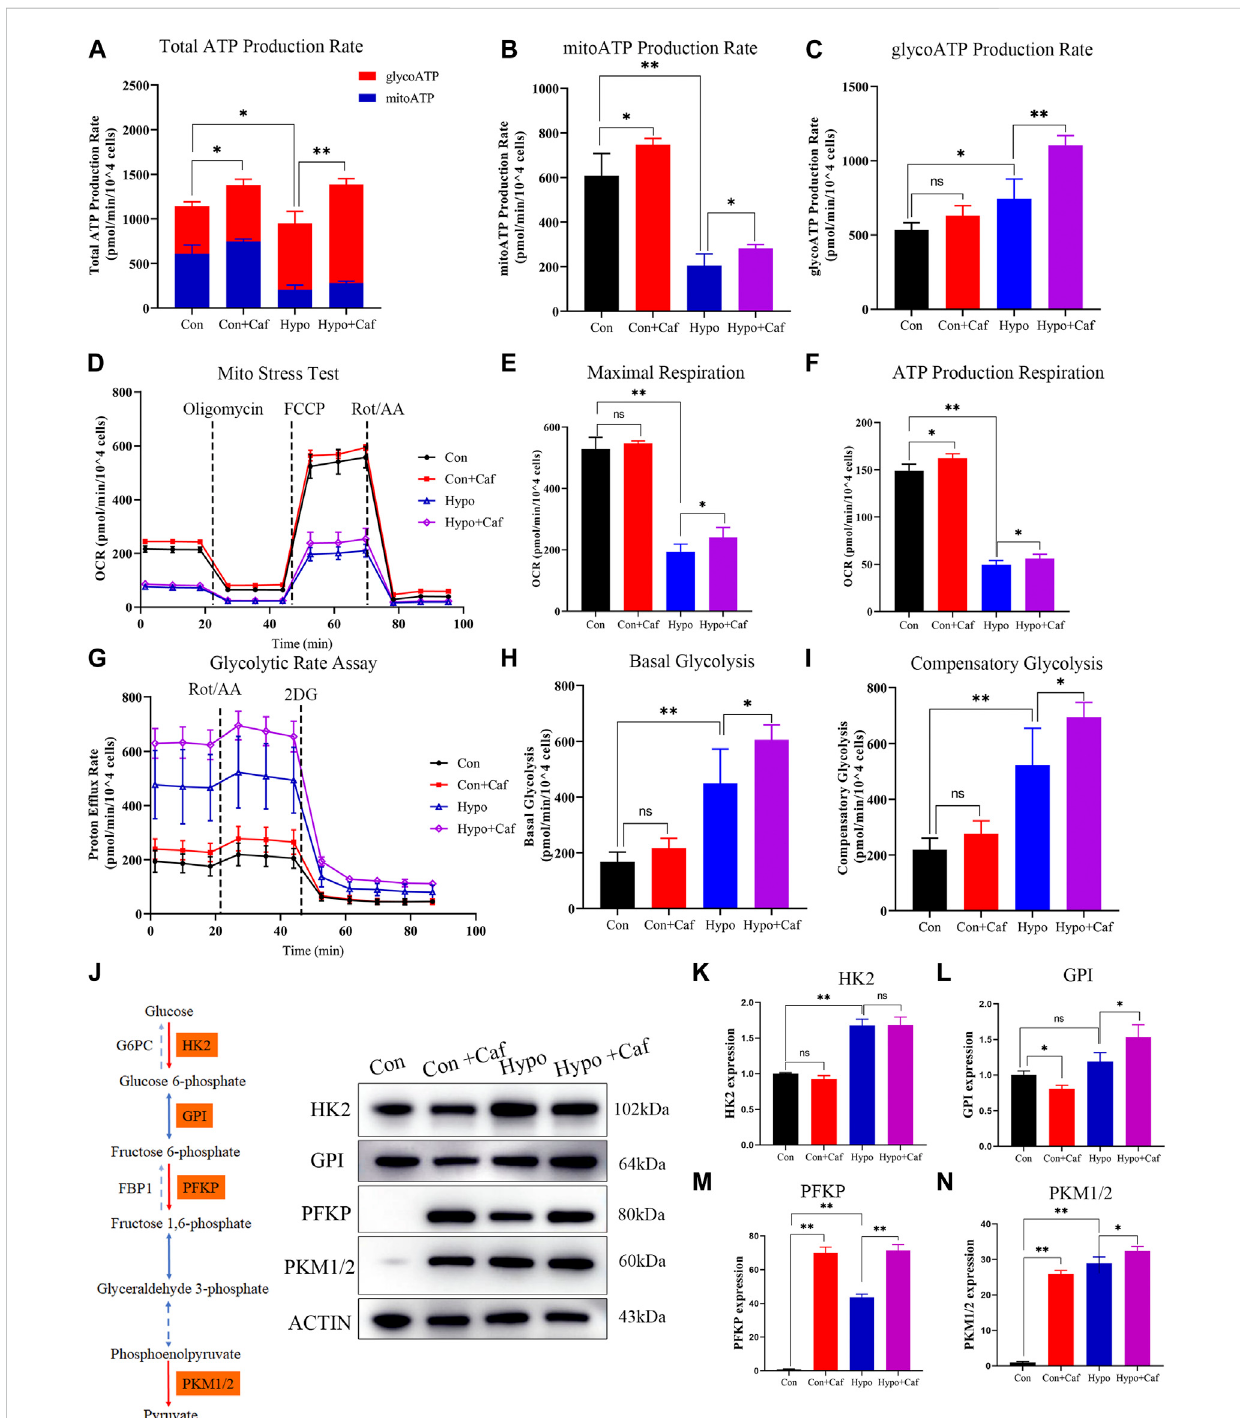
FIGURE 3 Effects of caffeine on mitochondrial ATP production. (A – C) The total ATP produced by mitochondrial oxidative phosphorylation and glycolysis. CaffeineincreasedthetotalATPproductioninnormoxia(Con+Cafgroupvs.Congroup)andhypoxia(Hypo+Cafgroupvs.Hypogroup). (B) RateofATP production produced by mitochondrial oxidative phosphorylation. The mitoATP production rate dramatically decreased in hypoxia, and caffeine can mitigate the decrease in the Hypo + Caf group. (C) Rate of ATP production produced by glycolysis. We found a signi fi cant increase in glycoATP production rate in hypoxia, and caffeine signi fi cantly ampli fi ed this change. (D) The OCR was measured using Seahorse XF Cell Mito Stress Test. (E) Maximal respiration and (F) ATP production respiration of the Mito Stress Test was calculated. Hypoxia decreased the maximal and ATP production respiration, and caffeine reversed these changes. (G) The rate of cellular glycolysis. By measuring the proton ef fl ux rate, we calculated the rate of glycolysis. (H) The basal glycolysis and (I) the compensatory glycolysis of mitochondria were calculated. Hypoxia caused the accumulation of basal